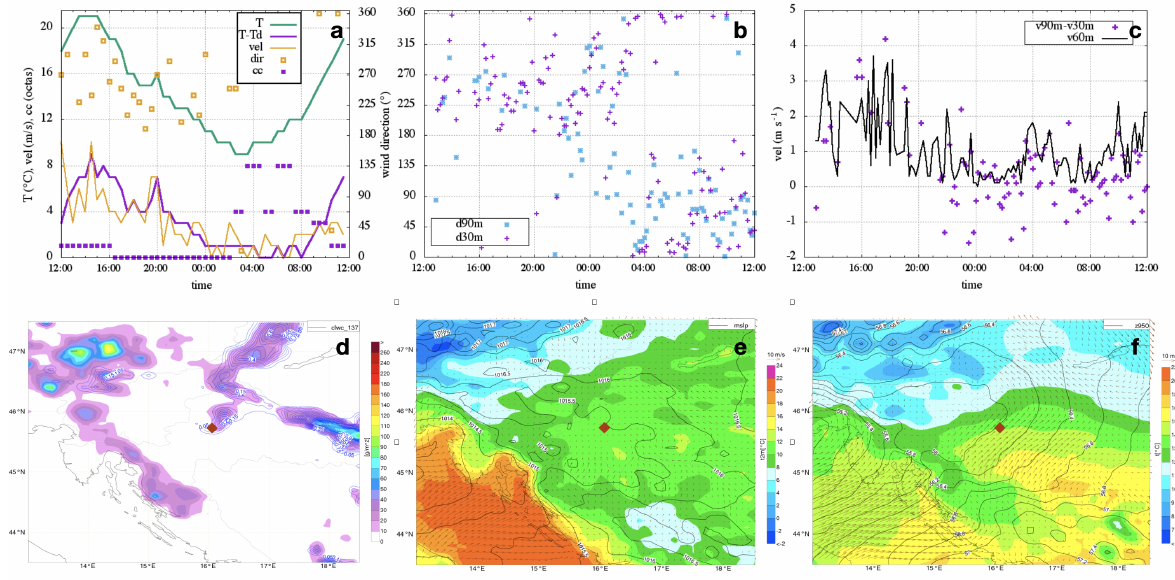
Figure 2. Summer intermittent fog on the Medvednica foothills, 17–18 September 2017. Top row: ( a ) half-hourly 24 h series of wind speed and direction at 10 m, T and dew point at 2 m, and cloud cover from ZGB METAR reports; ( b ) 15 min time series of wind direction at 10 m from METAR and 30 and 90 m from sodar; and ( c ) sodar wind speed at 60 m and speed difference between 90 and 30 m. Bottom row: ( d ) a zoom of ECMWF model centred in Zagreb (indicated by a rhombus) at 05 UTC showing fields of integrated liquid water contents 1 km above the surface; ( e ) 10 m wind, T2m and mean sea level pressure; and ( f ) geopotential height, wind, and T at 950